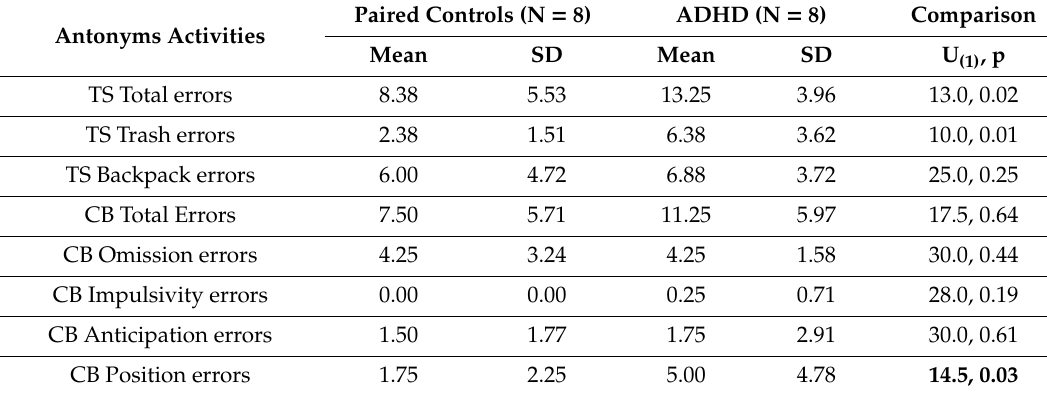
Table 2. Training School (TS) and Central Building (CB) scores in the ADHD groups vs. the control group. Di ff erences were tested using the Mann-Whitney U test, one-tailed. Alpha = 0.05 (statistical significance is marked in